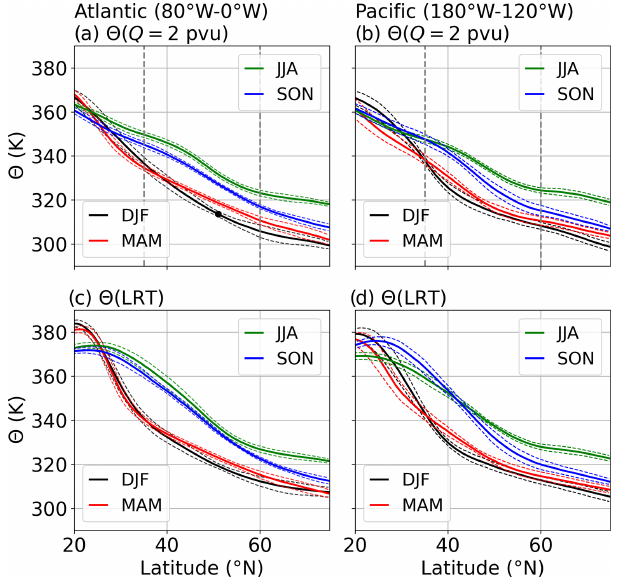
Figure 8. (a, b) Seasonal 10-year temporally and zonally averaged dynamic tropopause potential temperature ( (cid:50)(Q = 2pvu ) , in K). (c, d) Seasonal 10-year temporally and zonally averaged LRT po- tential temperature ( (cid:50) (LRT), in K). Solid lines show mean val- ues, and dashed lines interseasonal standard deviation. Left col- umn North Atlantic region (80–0 ◦ W). Right column eastern North Pacific region (180–120 ◦ W). The black dot in panel (a) indicates (cid:50)(Q = 2pvu ) at 51 ◦ N, where Fig. 9 is located. Dashed grey verti- cal lines in panels (a) and (b) indicate the borders of the region that is further analyzed.